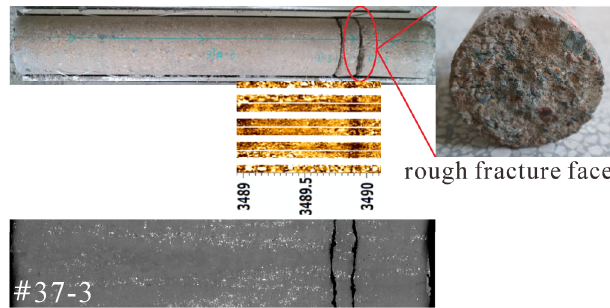
Figure 4. Features of a shear fracture.